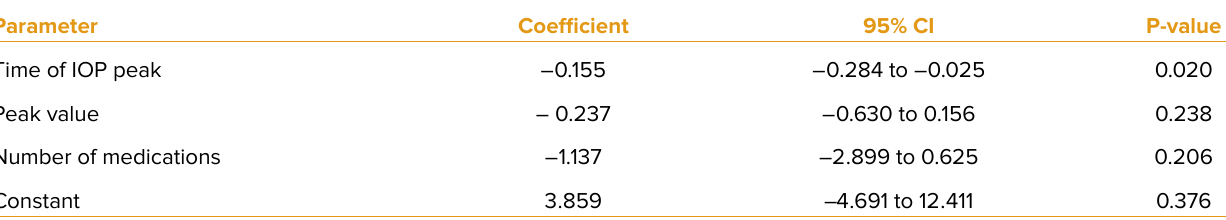
Table 3. Results of the mixed model evaluating the association between the MD and time of IOP peak, IOP peak value, and number of medications.